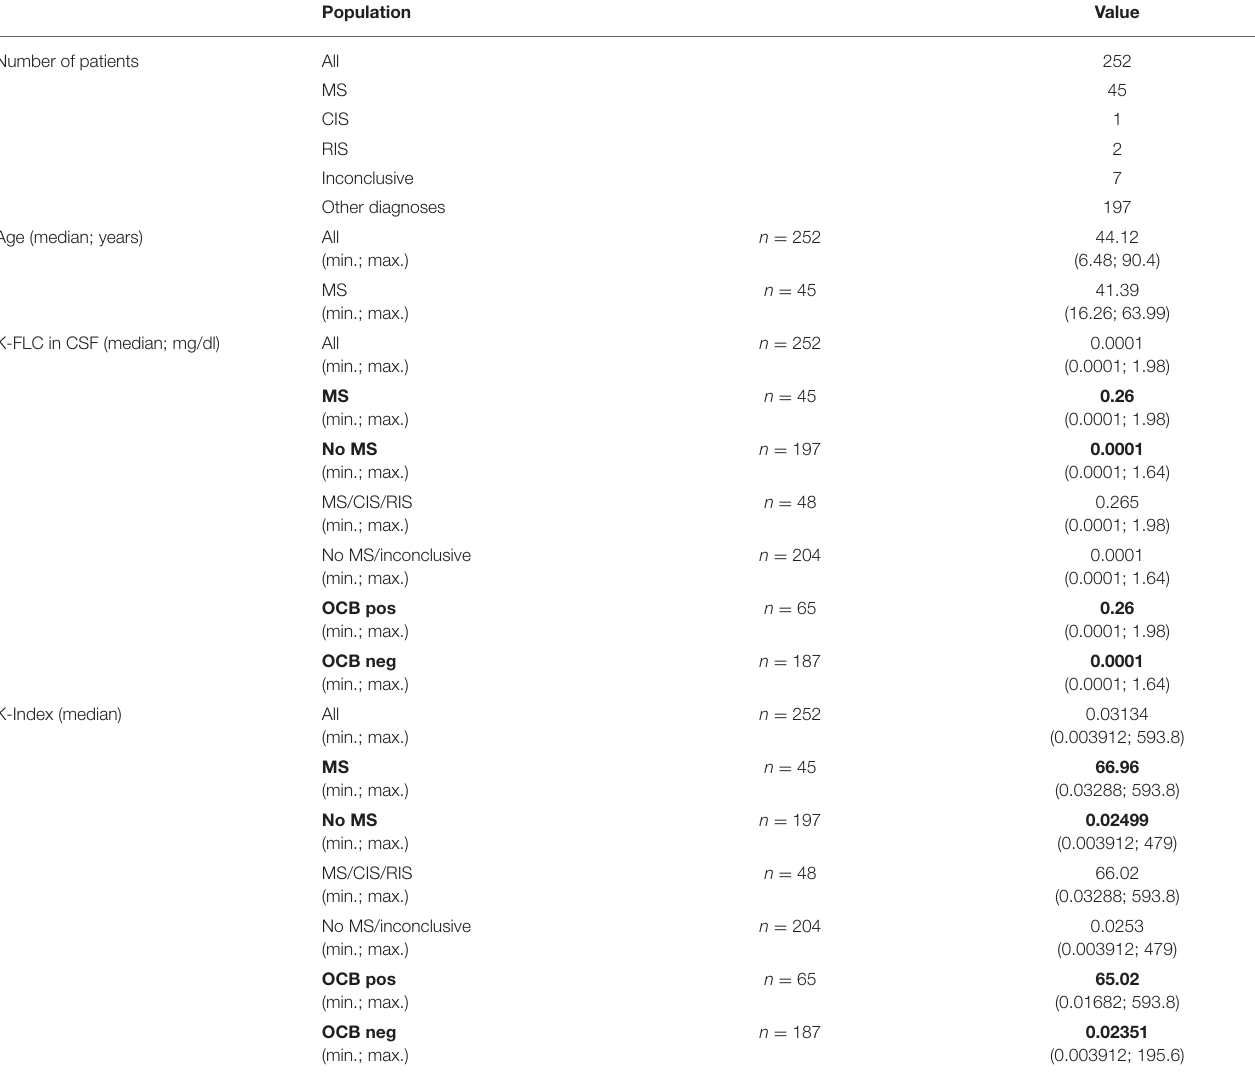
TABLE 1 | Patient’s